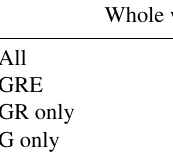
Table 1. Number of stations capable of receiving particular GNSS signals used in this study. Whole